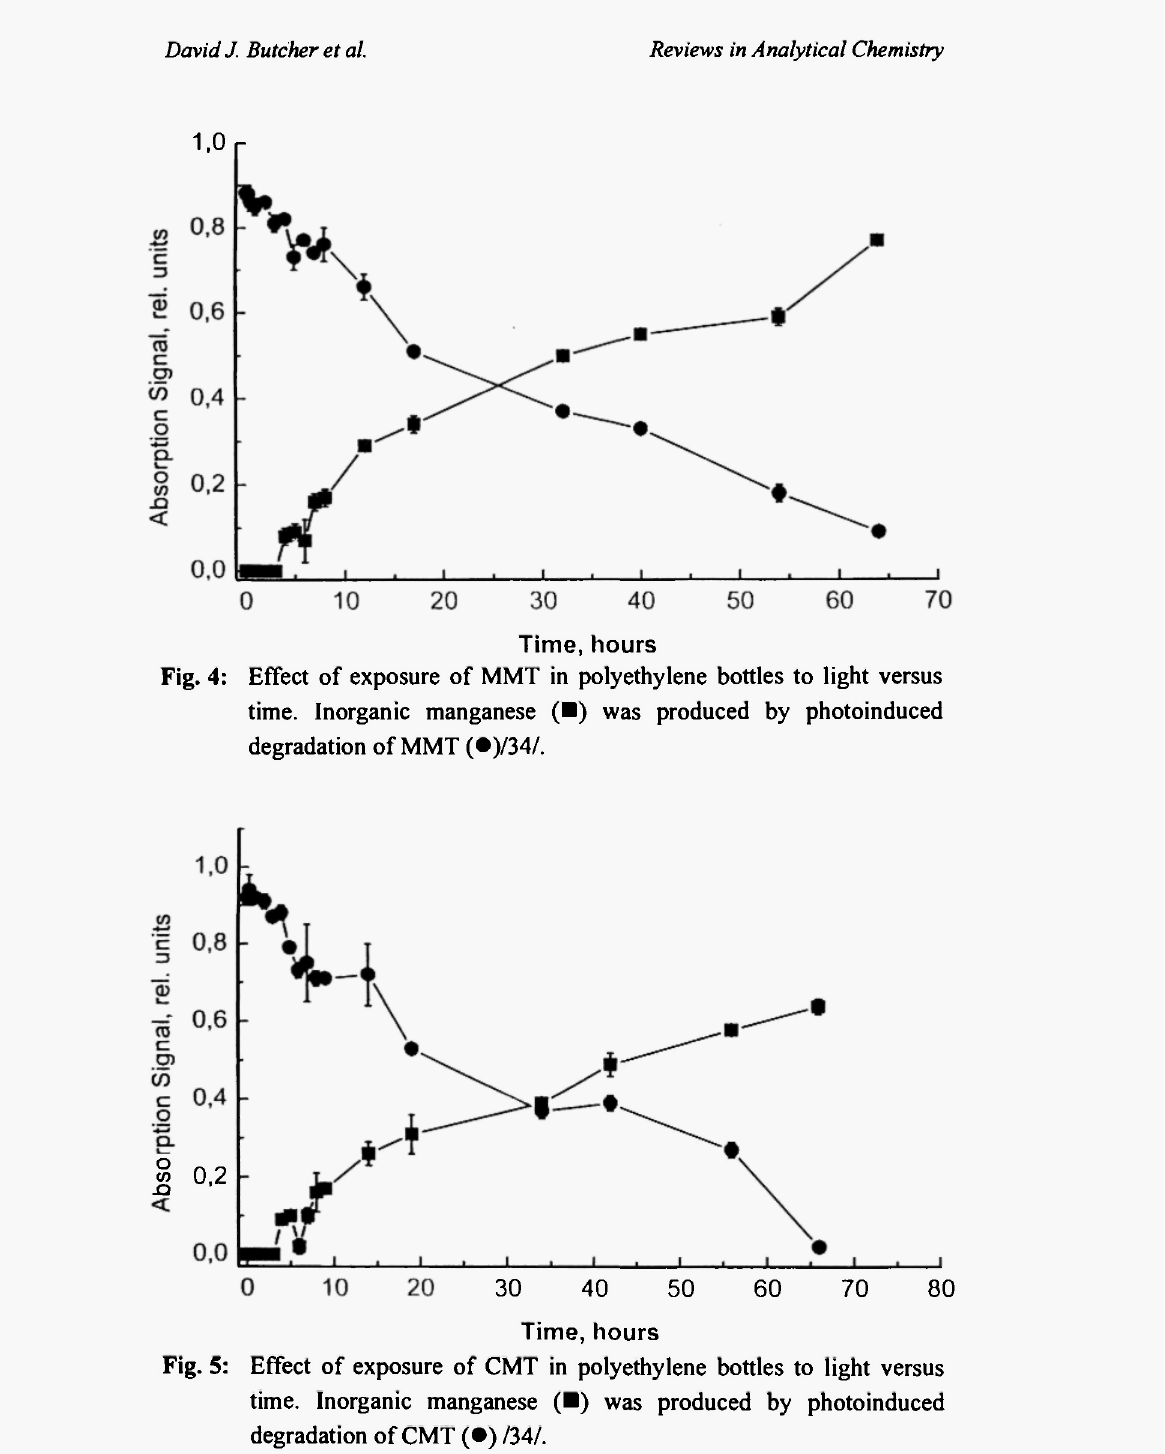
Fig. 5: Effect of exposure of CMT in polyethylene bottles to light versus time. Inorganic manganese ( •) was produced by photoinduced degradation of CMT ( ·)